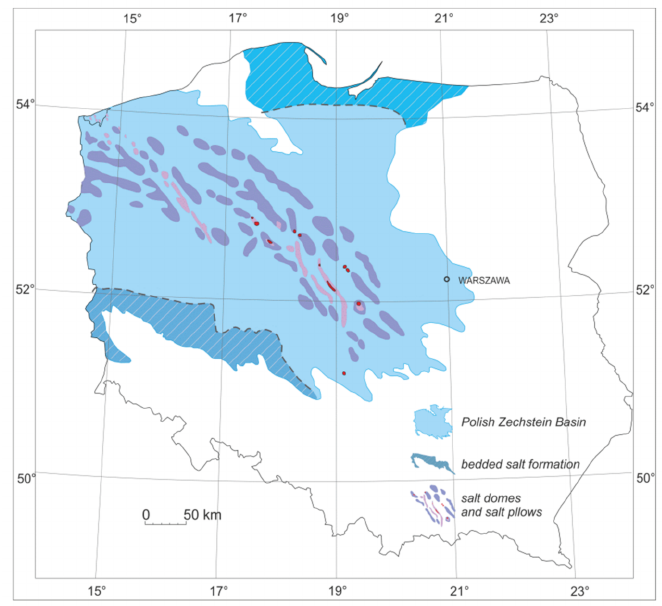
Figure 1. Zechstein Salt Formation (according to: Czapowski et al.